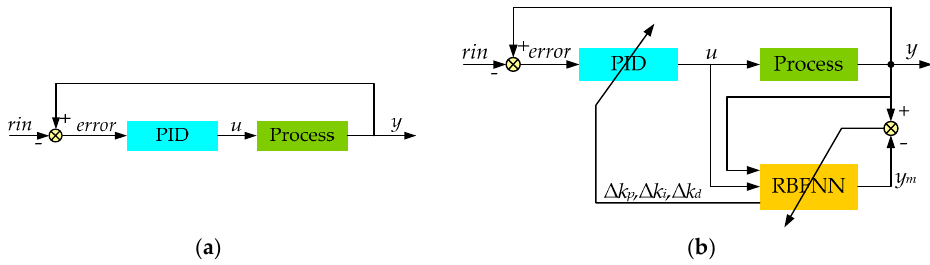
Figure 4. Block diagram comparing two controllers: ( a ) Block diagram of a traditional PID controller in a feedback loop; ( b ) Block diagram of proposed RBF neural network-based adaptive PID (RBFNNPID) controller. PID: Proportional-Integral-Derivative.